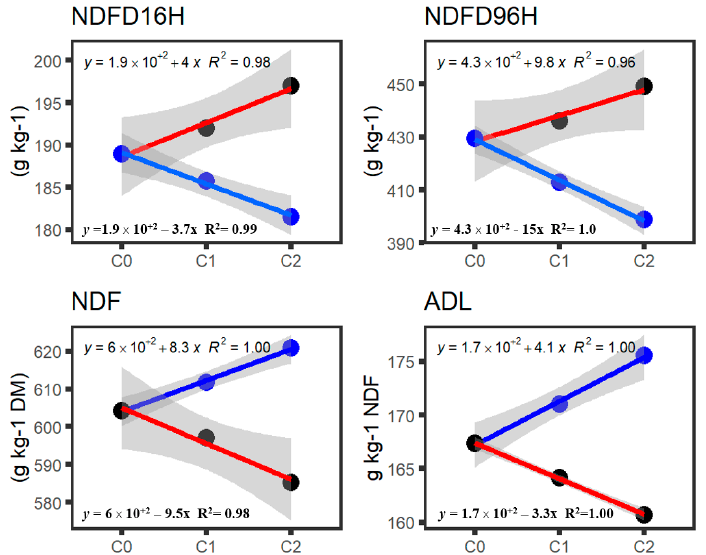
Figure 2. Responses in IVNDFD and CW components over two cycles of divergent selection. Popu- lations selected for high 16 h and high 96 h IVNDFD are in red, and populations selected for low 16 h IVNDFD and low 96 h IVNDFD are in blue. Gray shading around the regression line is the 95% confidence interval around the mean across years, locations, harvests, and maturities. Regression equations and R 2 over the two cycles are shown above or below each line.